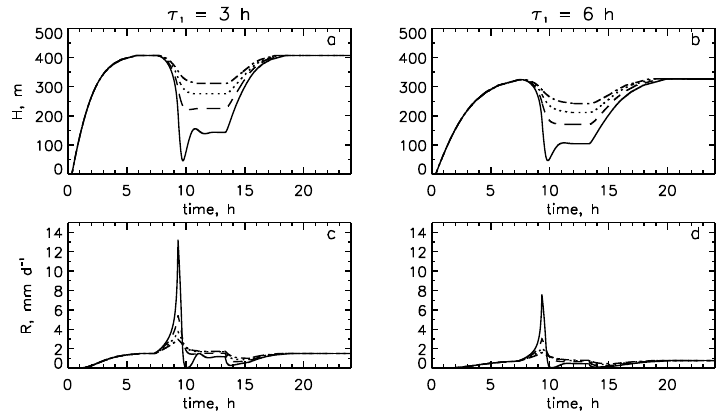
Figure 11. Predator–prey analog to the cloud system (Eqs. 1 and 3). N(t) is prescribed as in Fig. 1 but the timing is 4h later to allow for predator–prey model spin-up. Model parameters are H 0 = 650m, T = 20min. Left column: H and R solutions for H recovery time τ 1 = 3h; Right column: H and R solutions for τ 1 = 6h. Line types represent the various N time series (as in Fig. 1, but with N in cm − 3 ). In both cases the concurrence of rapid increase in R during the rapid reduction in LWP is simulated as in Fig. 3a, b. Smaller values of N perturbation exhibit faster H recovery after reintroduction of N . Recovery is also faster in the case of smaller τ 1